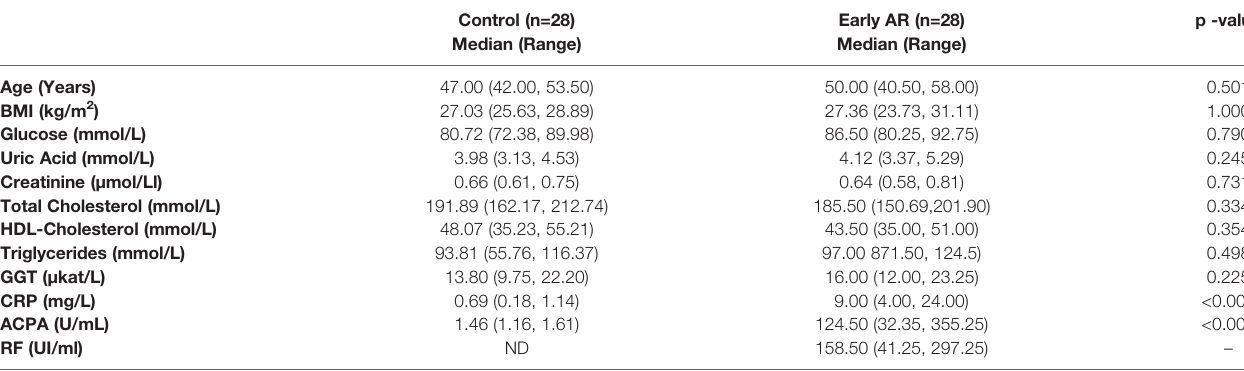
TABLE 1 | Patients ’